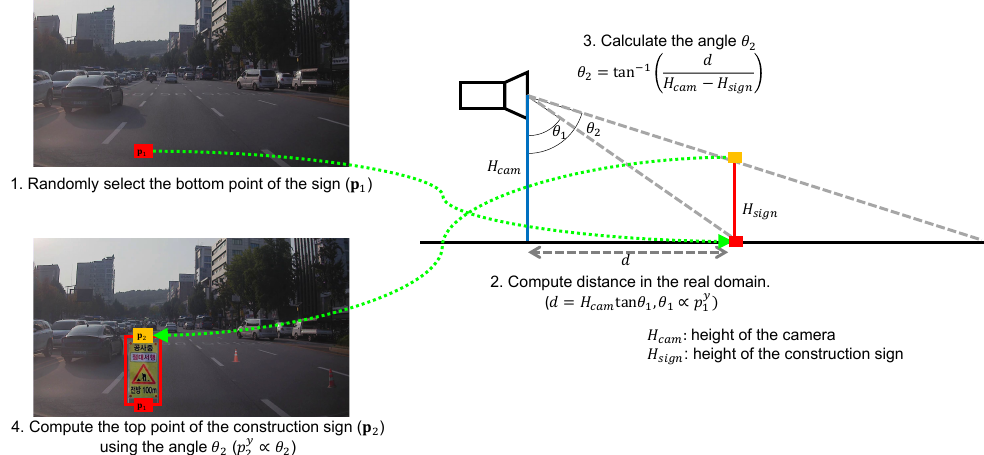
Figure 6. Step-by-step processes for computing the size of the construction sign. (1) We randomly select the bottom position of the construction sign in the image. The position is selected only within the pasteable region. (2) From the randomly selected point in the image, we estimate the angle θ 1 and compute the distance between the camera and the sign in the real domain. (3) We estimate the angle θ 2 by assuming that all construction signs have the same height H sign and stand perpendicular to the road. (4) Using the estimated angle θ 2 , we compute the point of the top of the construction sign in the